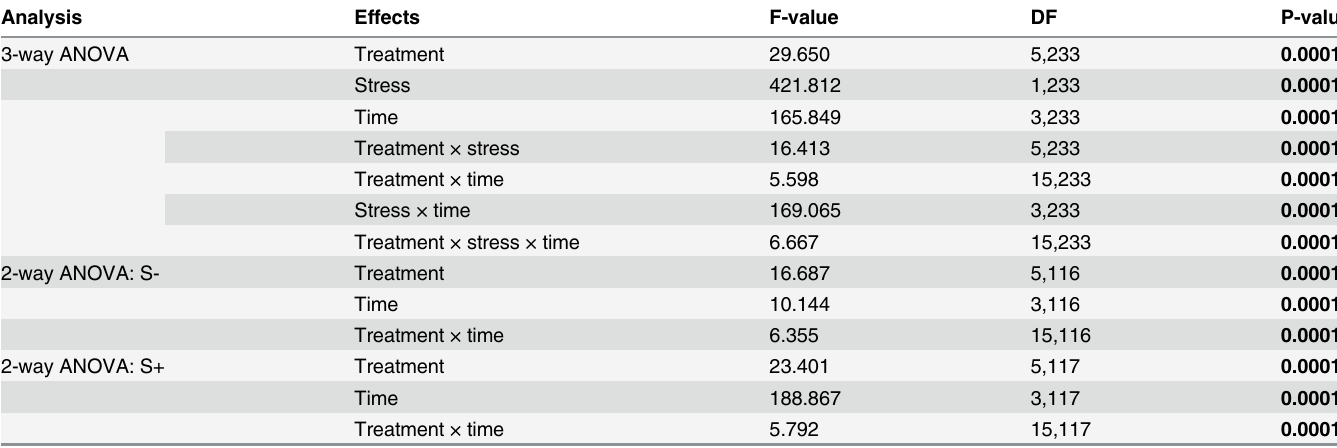
Table 1. Results of analysis of variance (ANOVA) for cortisol